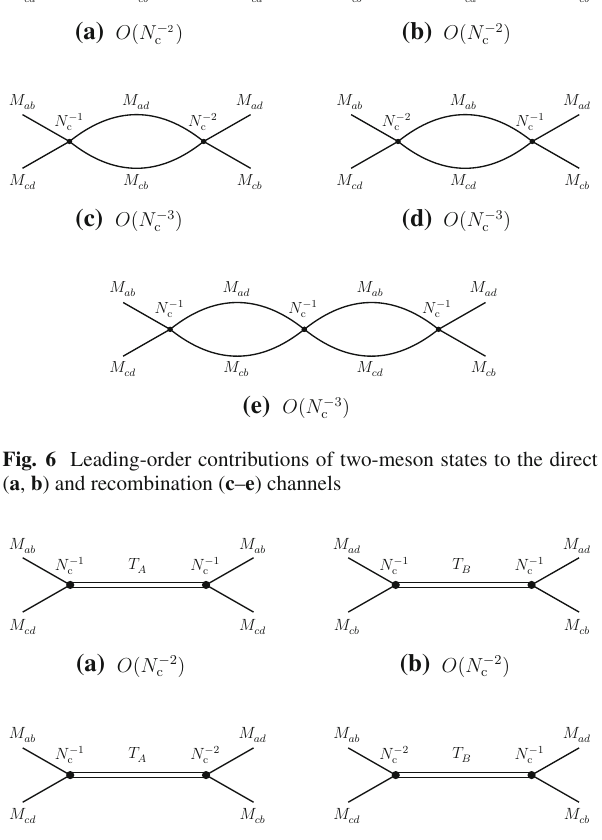
and T to the A B